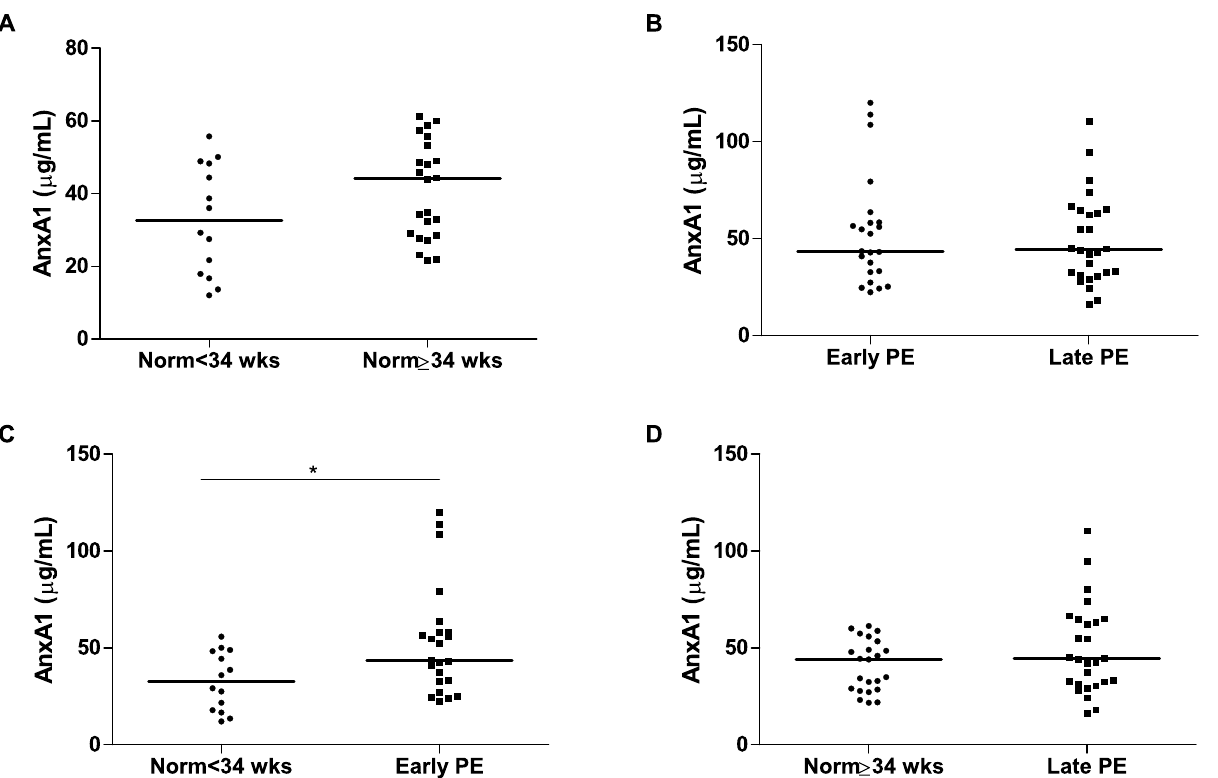
Fig 2. AnxA1 plasma levels in normotensive pregnant and PE women according to gestational age. Norm < 34 wks (normotensive pregnant women with GA < 34 weeks), Norm (cid:1) 34 wks (normotensive pregnant women with GA (cid:1) 34 weeks), PE (preeclampsia). Horizontal bars represent median for AnxA1 levels (micrograms/milliliter). * P < 0.05. AnxA1 plasma levels were higher in pregnant women with early PE than in normotensive pregnant women with GA < 34 weeks (C). No significant differences were detected between the normotensive pregnant subgroups (A), early and late PE (B) and normotensive pregnant women with GA (cid:1) 34 weeks and pregnant women with late PE